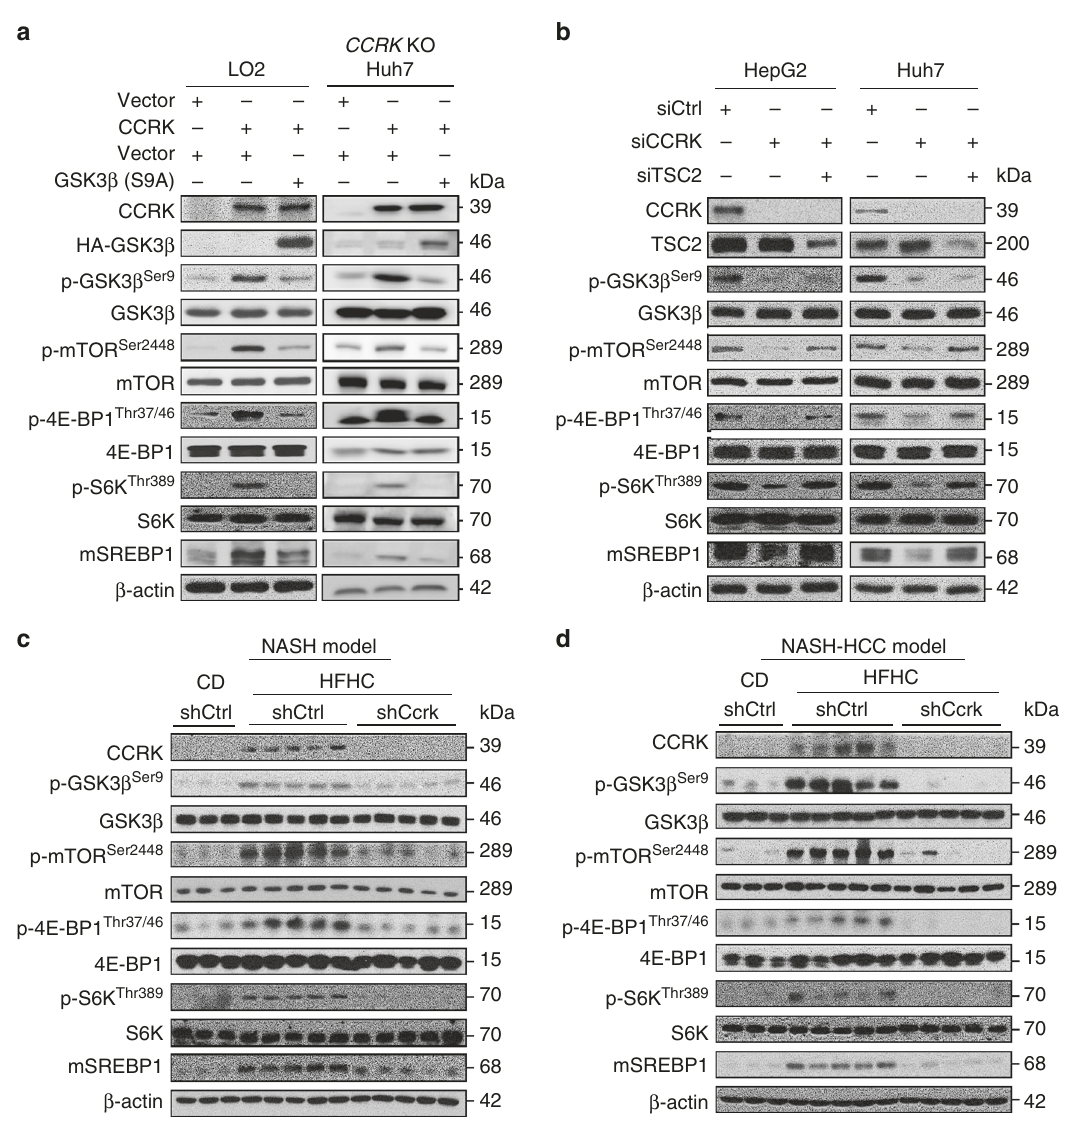
Fig. 4 CCRK activates mTORC1 signaling through GSK3 β /TSC2 cascade. a Ectopic CCRK expression in LO2 and CCRK KO Huh7 cells activates mTORC1 signaling, which was abrogated by suppression of GSK3 β phosphorylation at Ser9 (p-GSK3 β Ser9 ) via over-expression of the constitutively-active S9A-GSK3 β mutant. Western blot analysis was used to detect the protein expression of mTORC1 downstream molecules. b Knockdown of CCRK in HepG2 and Huh7 cells impaired the activation of mTORC1 signaling, which was rescued by the silencing of TSC2. c , d Dietary obesity-induced CCRK expression is responsible for the activation of mTORC1 signaling cascades in both c NASH and d NASH-HCC models, and such CCRK-dependent effects were abolished following knockdown of Ccrk . The establishment of NASH and NASH-HCC models are as described in Figs. 1a and